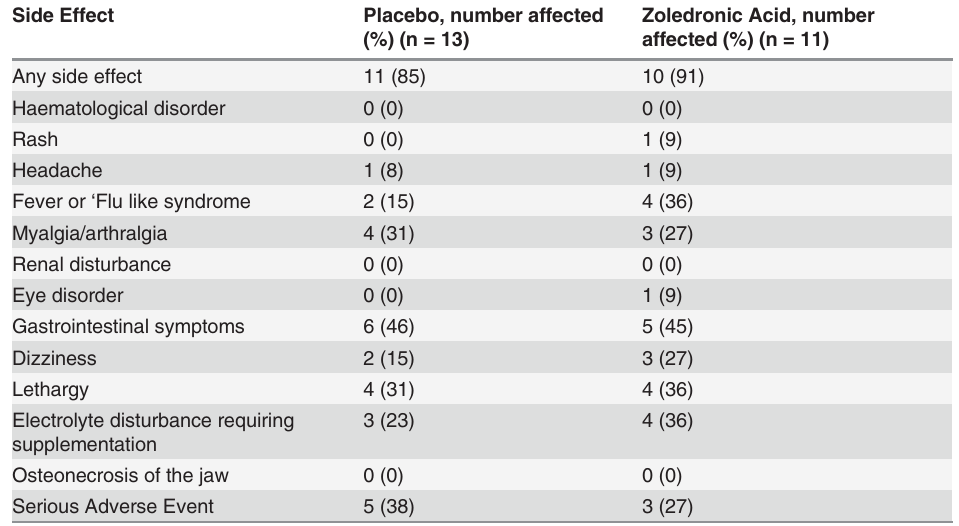
Table 2. Side effects and adverse